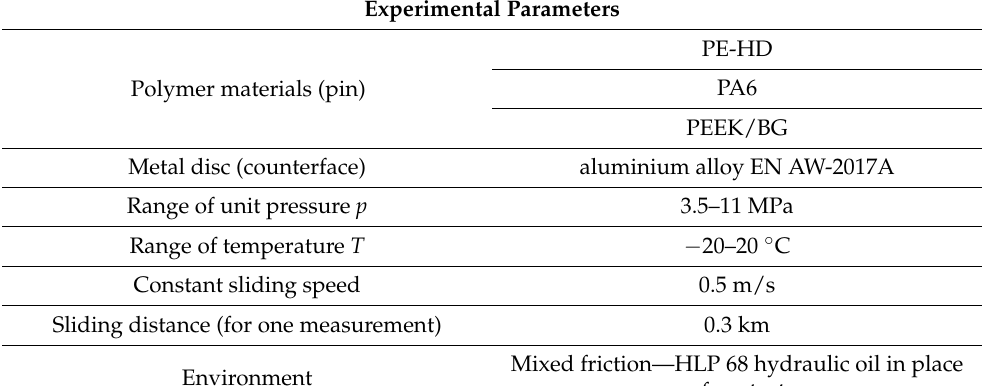
Table 4. Tribological test parameters.